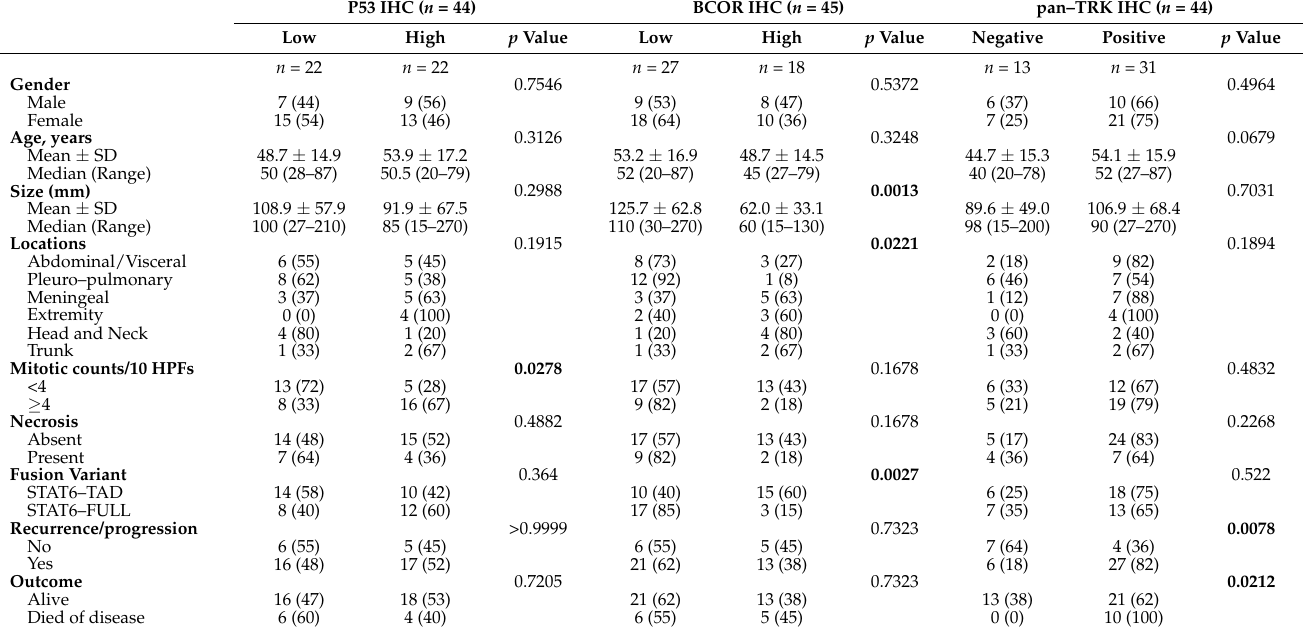
Table 3. Associations of IHC markers with clinicopathological parameters and gene fusion